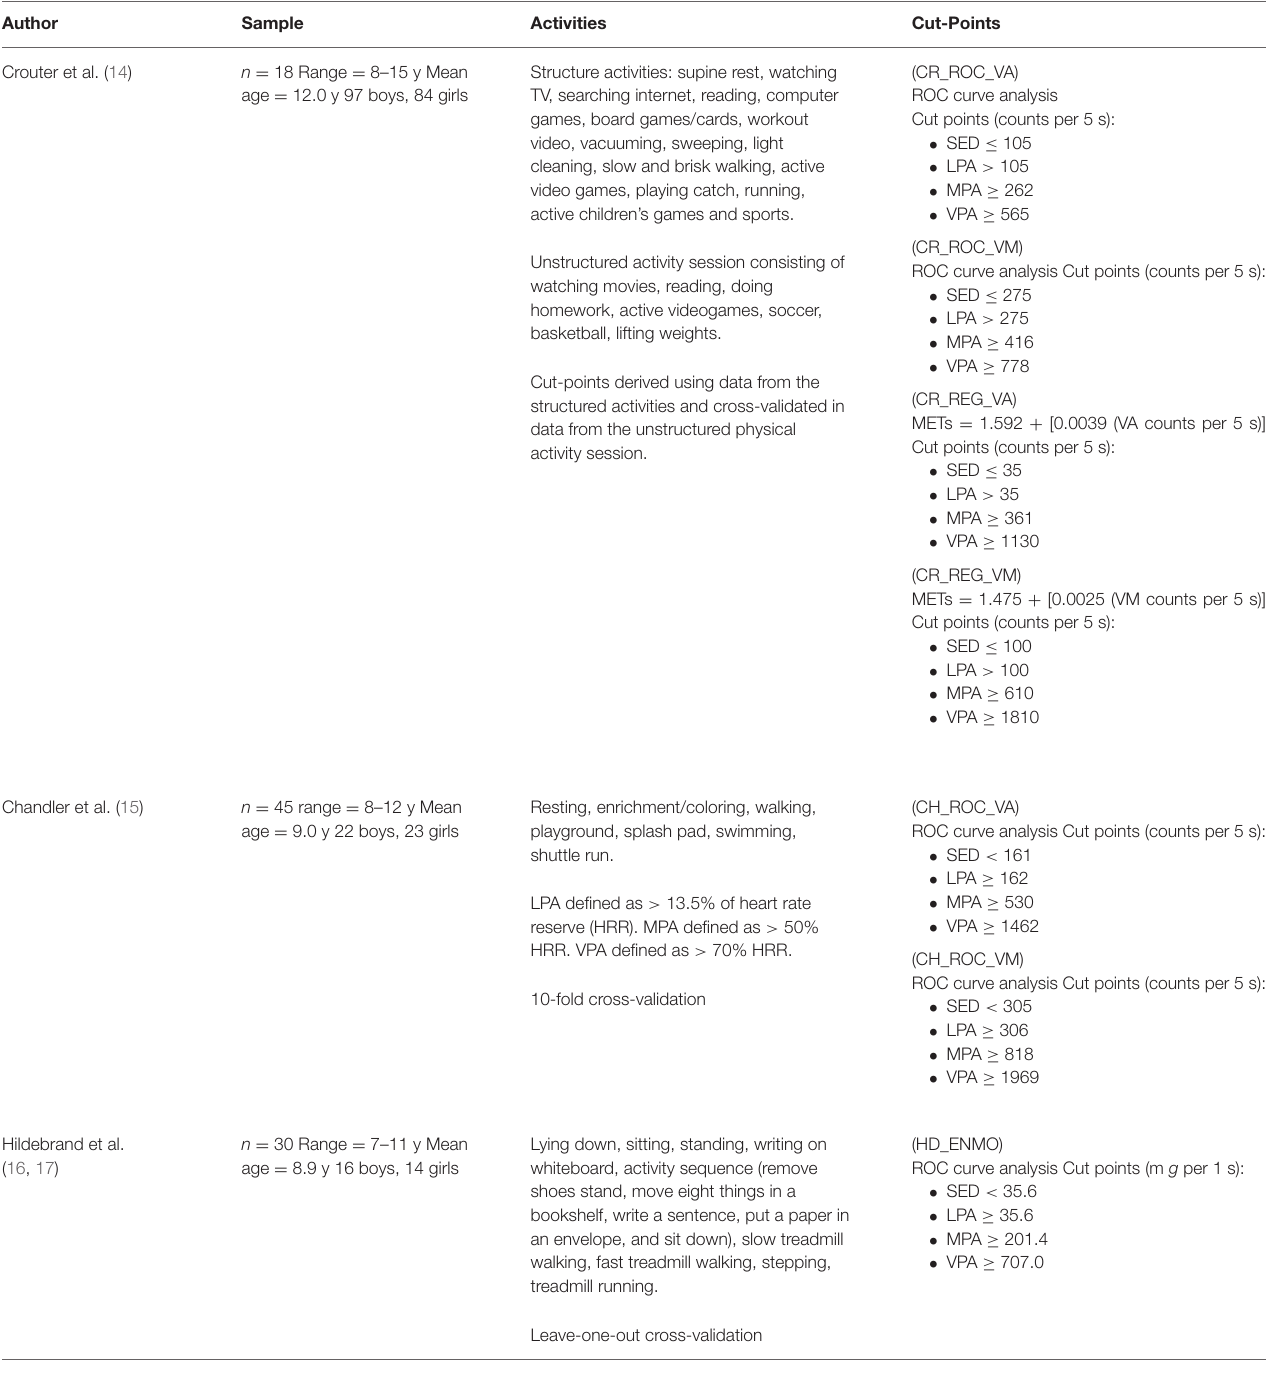
TABLE 1 | Youth specific cut points for the ActiGraph accelerometer worn on the